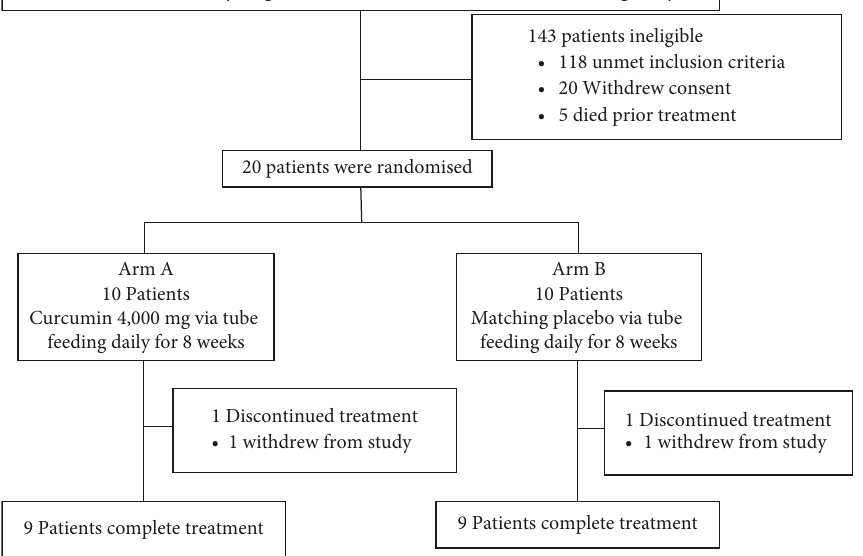
Figure 1: Consort flow diagram showing patients included in the study. Table 1: Baseline characteristics of the patients (intention-to-treat